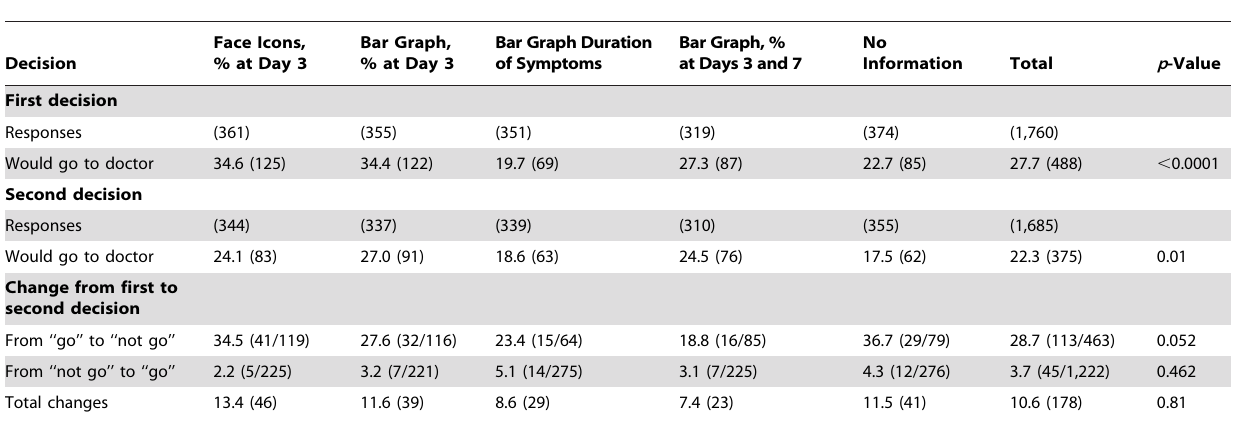
Table 2. Decisions to go to the